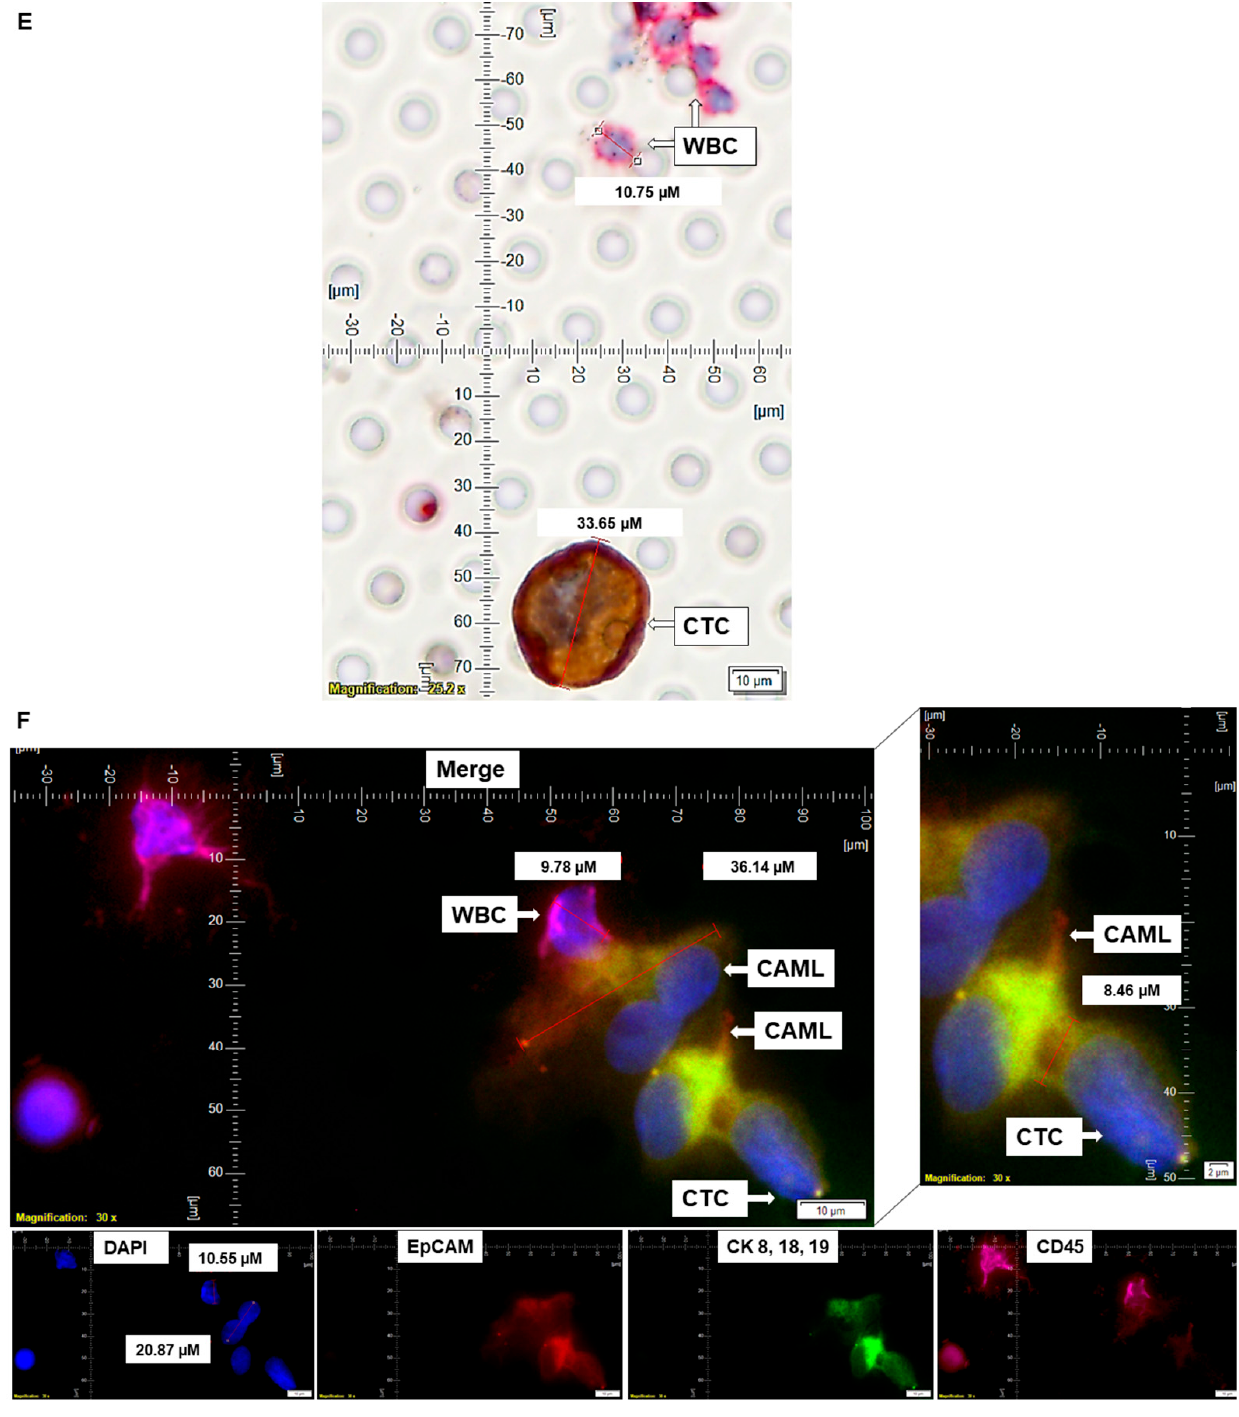
Figure 5. Representative presentation of co-identification of tiny/giant CAMLs and CTC in the blood sample of a patient with endometrioid endometrial adenocarcinoma. A blood sample was used to isolate and enumerate CAMLs and CTCs by triple immunofluorescence and double immunocytochemistry methods. The patient's blood samples exhibited tiny CAMLs by triple immunofluorescence ( A ), giant CAMLs by immunofluorescence ( B ), tiny (33.51 µM) CAML as well as a giant (52.67 µM) CAML by double immunocytochemistry ( C ), CTC by triple immunofluorescence ( D ), and CTC by double immunocytochemistry ( E ) methods. We identified one CTC–CAML–WBC cluster ( F ) in the same blood sample. ( D ) presents the DAPI signal in cyan to clarify better the "salt–pepper" image of